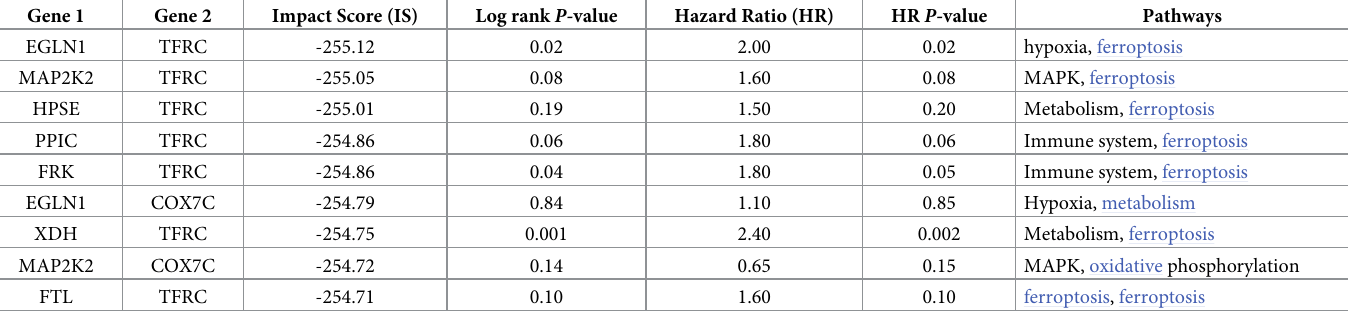
Table 2. Analysis of overall survival among the nine top-ranked target combinations in pancreatic ductal adenocarcinoma (PDAC). Here IS closes to the lower nega- tive number is, the more support for synergy to the candidator of pairwise genes.